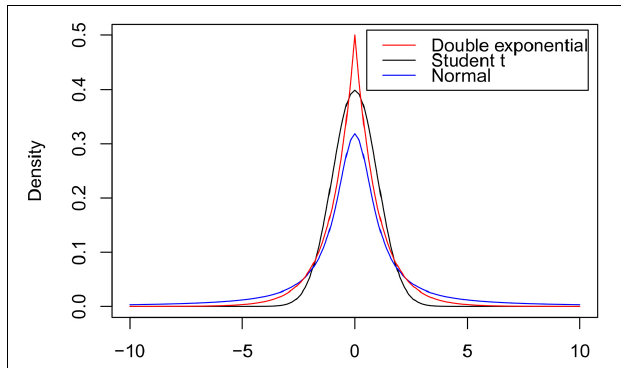
FIGURE 4 | Probability density functions of the double exponential, Student’s t, and normal distributions, all with means equal to zero and variances equal to the